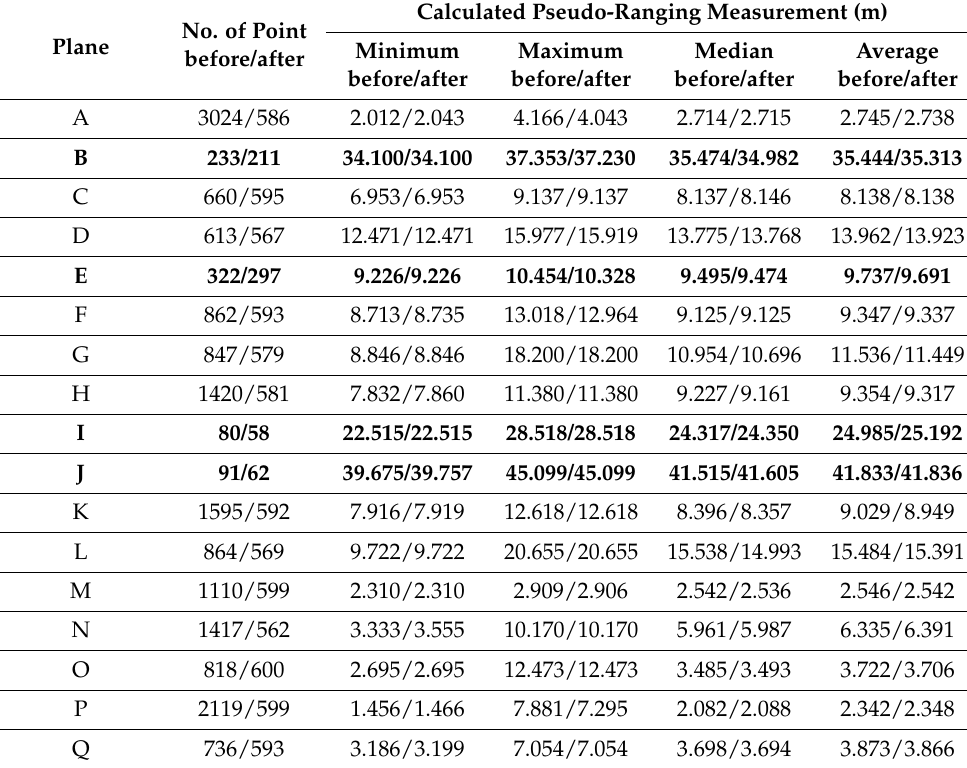
Table 5. The statistics of pseudo-ranging measurements in each plane for calibration data before and after subsampling and blunder removing by the RANSAC algorithm for calibration data. Calculated Pseudo-Ranging Measurement (m) No. of Point Plane Minimum before/after